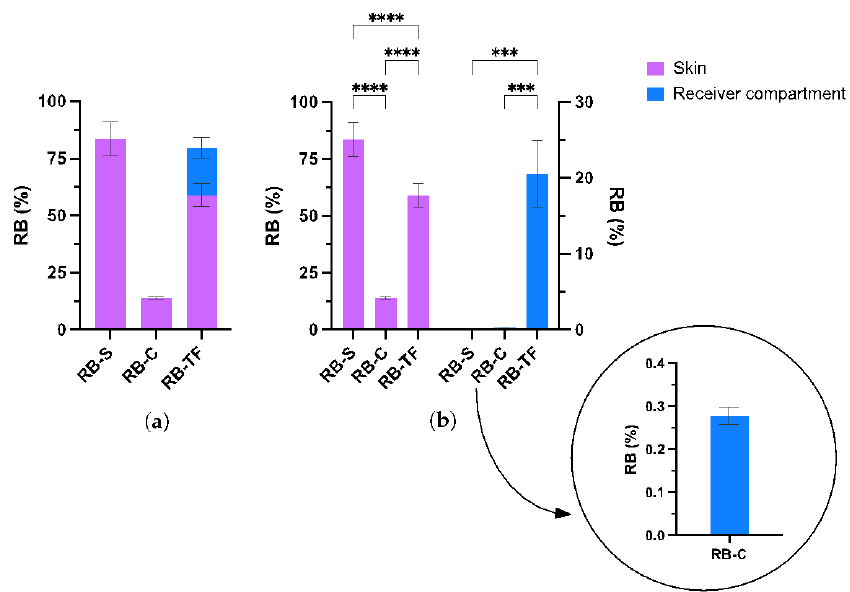
Figure 7. Amount of RB recovered after 24 h of an ex vivo deposition study across dermatomed porcine skin ( n = 3). ( a ) Illustration of the total amount of RB detected at the end of the study. ( b ) Focus on the amount of RB detected within the skin layers and in the receptor compartment. **** p - value < 0.001, and *** p -value < 0.01. The percentage of RB deposited into the skin was 83.57 ± 7.52 in the case of RB-S, 13.86 ± 0.48 in the case of RB-C and 59.07 ± 5.06 per RB-TF. At the same time, the percent- age of RB permeated into the receiver compartment was 0.28 ± 0.02 and 20.53 ± 4.41 in the case of RB-C and RB-TF, respectively. In contrast, RB did not permeate across the skin when delivered by RB-S. The reported data agrees with the characteristics of the prepared RB-loaded delivery system. The poor permeation profile for RB-S may be attributed to the physicochemical properties of the drug. The stratum corneum (SC) is the main barrier to the penetration of external agents. This is especially true for molecules exceeding 500 Da possessing anionic or cationic charges. RB disodium salt is a highly water-soluble amphiphilic drug with two anionic charges in the solution and a molecular weight of 1017.64 g/mol. RB aqueous so- lution (RB-S) did not permeate across the skin, and most of it was deposited into the skin tissue. In this investigation, no physical separation of epidermis and dermis was per- formed; however, RB is likely to accumulate in the epidermal layer without significantly reaching the dermis, as demonstrated in our previous work [30,38]. Incorporating RB into the aqueous cream (RB-C) led to the lowest deposition and permeation efficacy compared